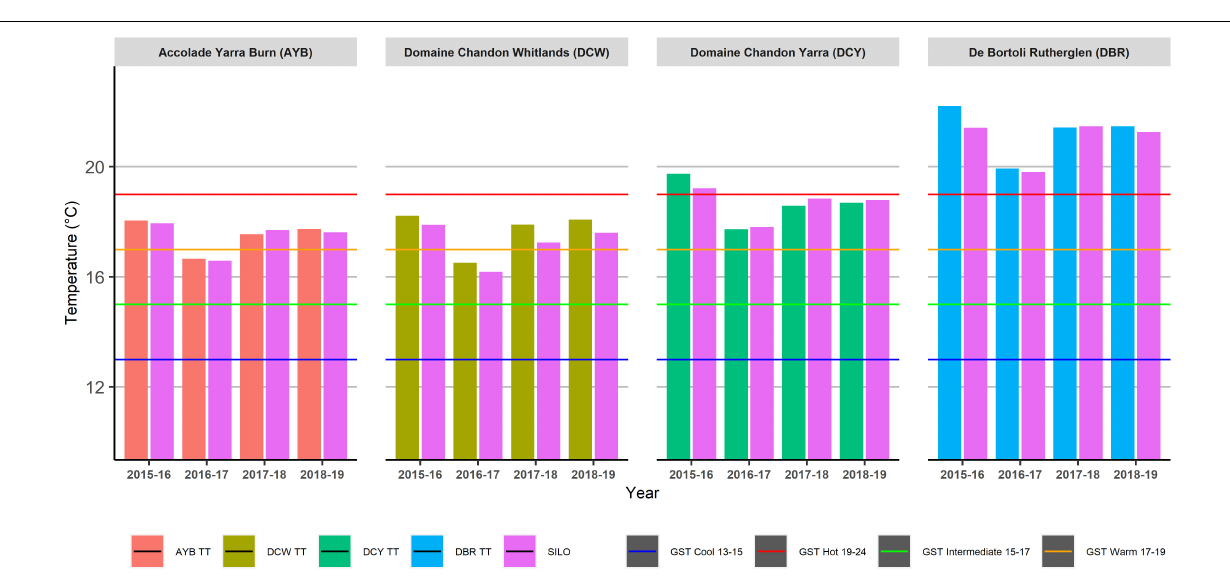
FIGURE 4 | Average Growing Season Temperatures (GSTavg) of four sites across four seasons as calculated using Tinytag (TT) or Scientific Information for Landowners (SILO)